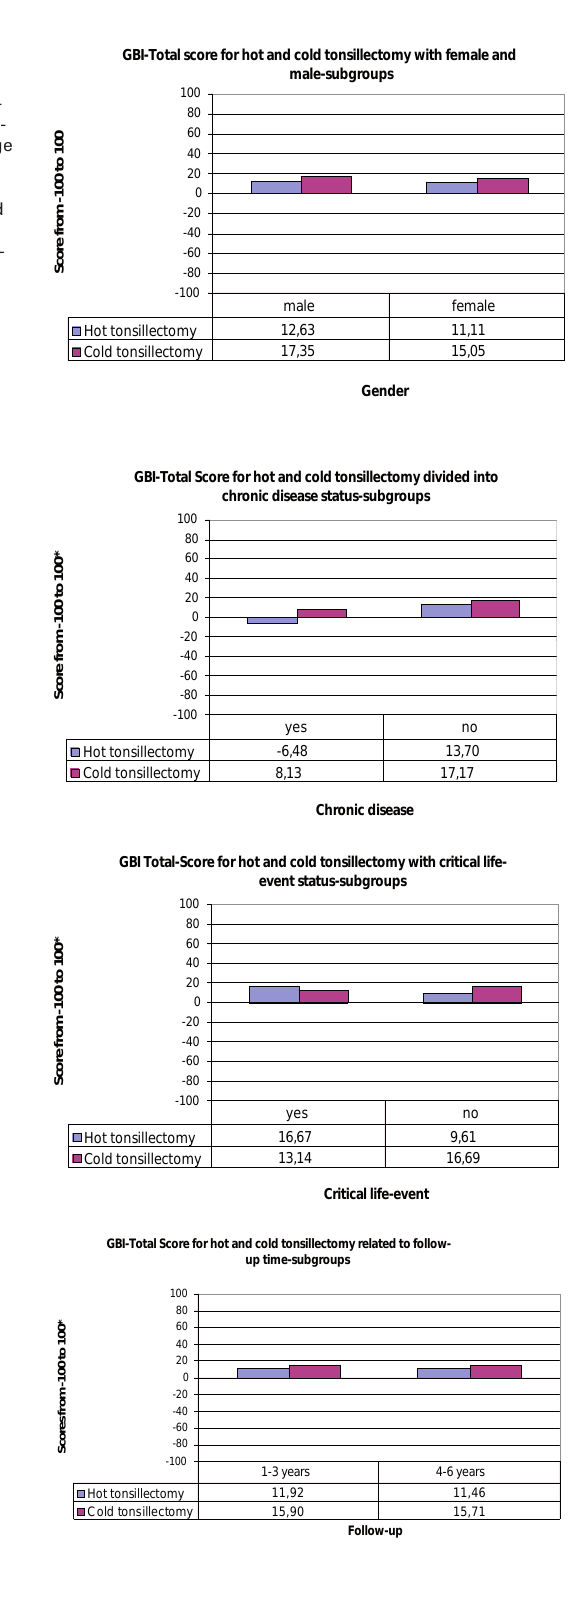
Figure 2 GBI Total Score for Gender, Chronic dis- ease and Critical life- event (* Scores range from –100 to 100, where –100 means negative change and 100 means positive change in health sta- tus since